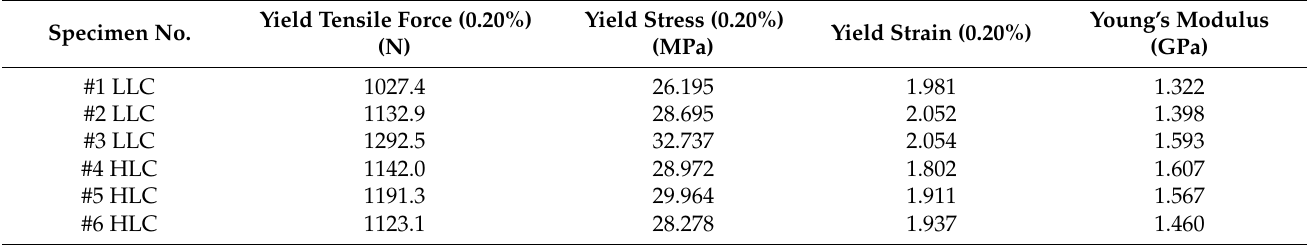
Table 7. Values of elasticity modulus obtained for LLC and HLC